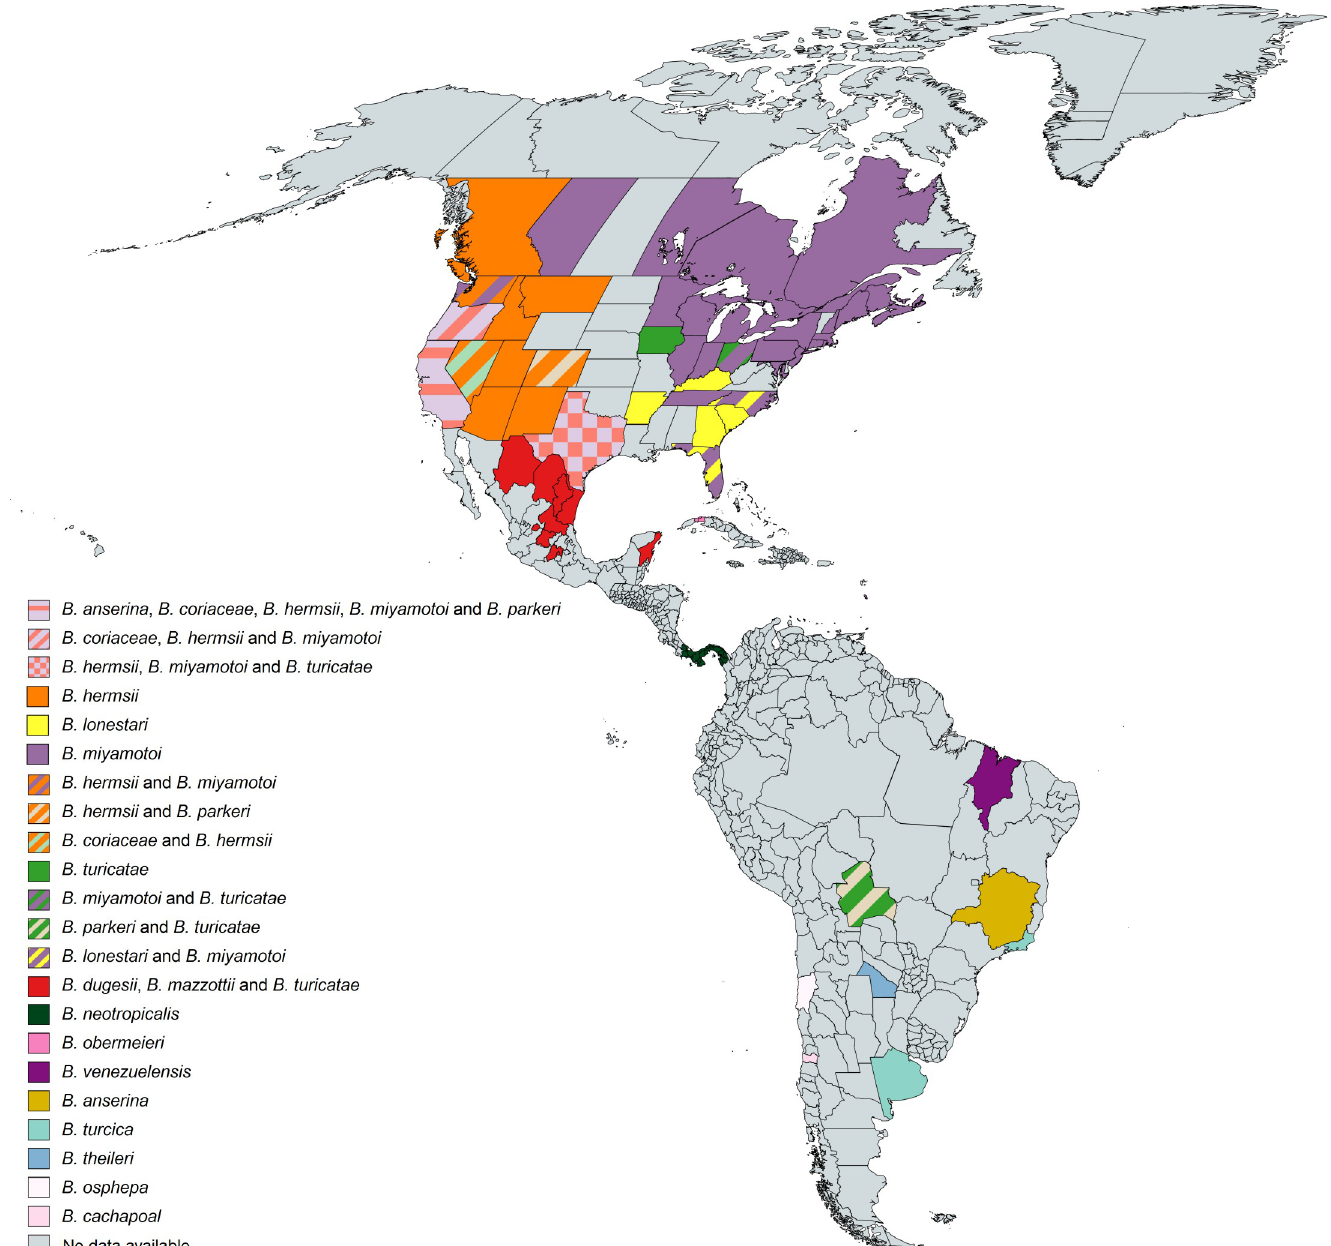
Fig 7. Reported presence of TBRF Borrelia species in ticks and animal hosts in America. B., Borrelia . Map created on www.mapchart.net. Known and putative TBRF spp. and their animal host(s) and transmitting tick species 124 studies reported data on Borrelia spp. and their associated animal hosts and transmitting ticks. Table 3 lists the known humanpathogenic TBRF Borrelia spp. as well as Borrelia spp. with yet unknown humanpathogenic potential, their known animal hosts and transmitting tick species.